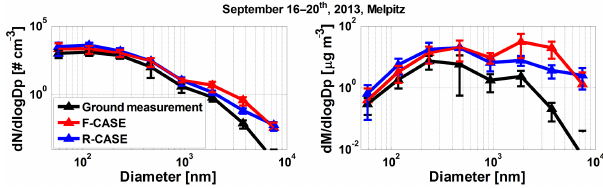
Figure 4. Comparison of particle number size distribution (PNSD, left) and particle mass size distribution (PMSD, right) between sim- ulation results (F-CASE and R-CASE) and Melpitz measurements. The results are averaged during 16–20 September 2013; the error bars indicate the upper and lower limits.